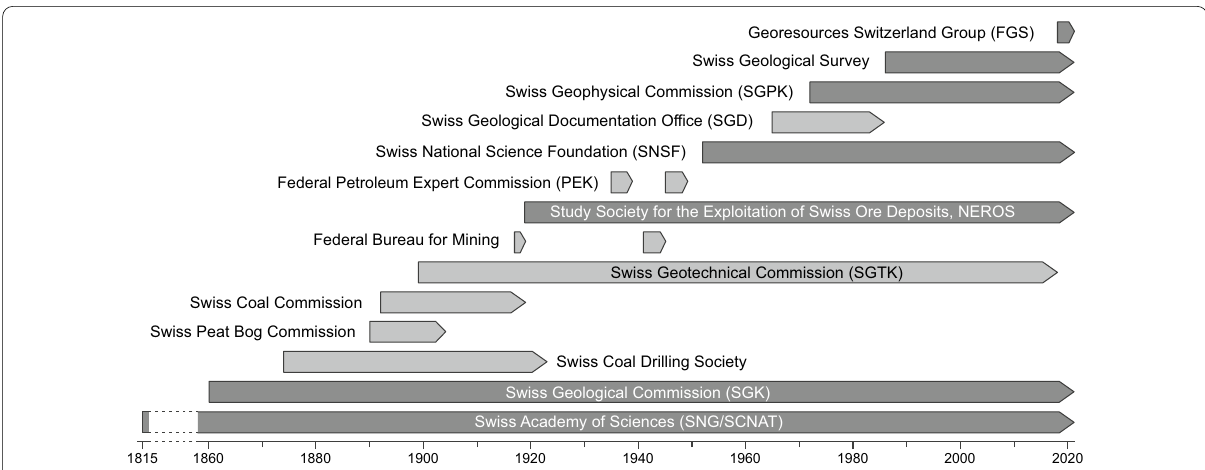
Fig. 2 Chronological overview on the georesources-related Swiss institutions discussed in the text. Arrows in dark grey mark institutions still existing today. Relationships between these institutions are shown in Fig. 3. Note that the term Swiss Geological Survey is used here in a wider sense and includes the survey’s predecessor institutions LHG and BWG (see Fig. 3 for details). The abbreviations are derived mostly from the